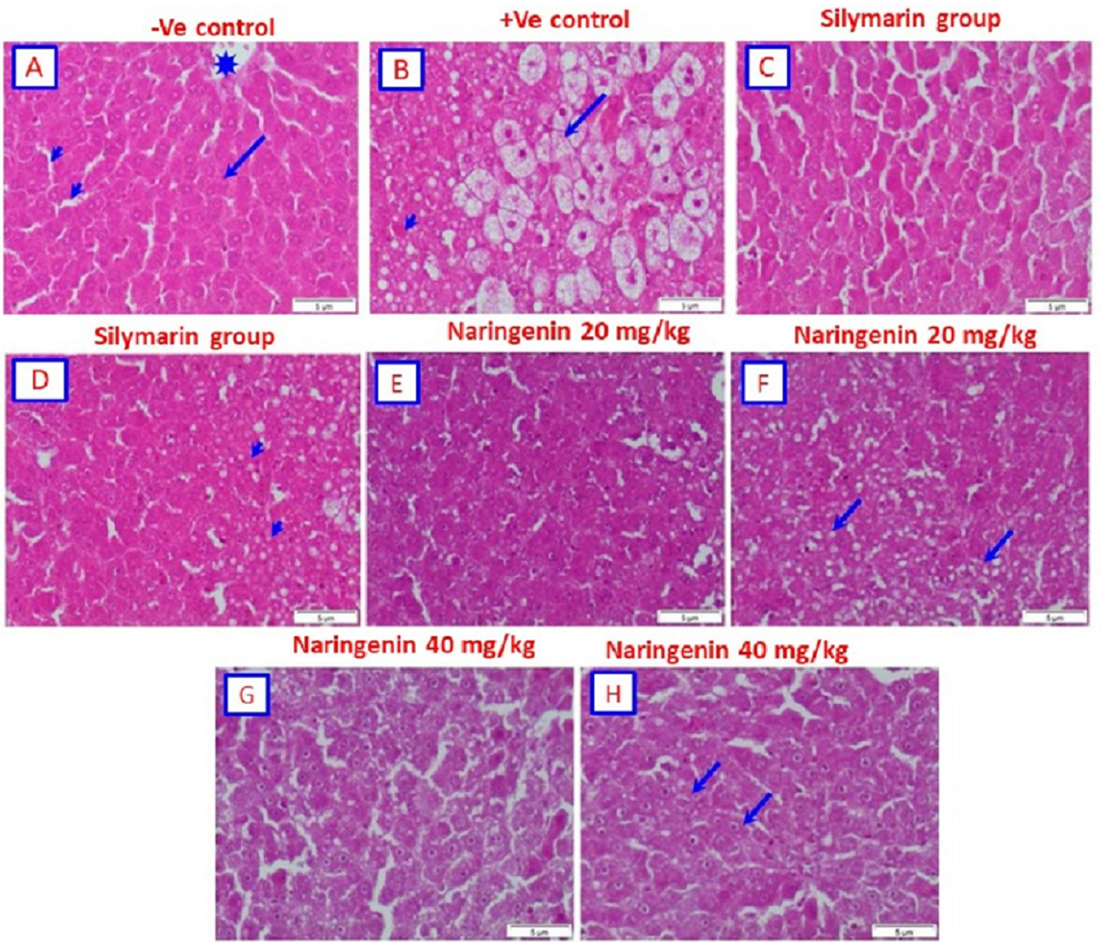
Figure 1. Photomicrograph of the liver tissues using hematoxylin and eosin (H&E) staining: ( A ) Negative control rats showing the normal structure of the hepatic lobule. The central vein (asterisk) is at the center of the lobule, which is surrounded by cords of hepatocytes (arrow). The hepatic sinusoids are shown between the strands of hepatocytes (arrowheads). ( B ) Rat given CCl 4 (positive control) showing large vacuoles in the cytoplasm with displacement of nuclei. The cytoplasm of the hepatocytes (arrowheads) has an even pale appearance, similar to ground glass. The hepatocytes undergo hydropic degeneration and become swollen and vacuolated (arrow), while some hepatocytes show an accumulation of eosinophilic material known as Mallory’s hyaline. ( C ) Rat given CCl 4 and treated with silymarin showing hepatocytes that appear as more or less normal. ( D ) Rat given CCl 4 and treated with silymarin showing hepatocytes associated with small vacuoles. ( E ) Rat given CCl 4 and treated with (20 mg/kg) naringenin showing hepatocytes that appear as more or less normal. ( F ) Rat given CCl 4 and treated with (20 mg/kg) naringenin showing hepatocytes associated with small vacuoles. ( G ) Rat given CCl 4 and treated with (40 mg/kg) naringenin showing hepatocytes that appear as more or less normal. ( H ) Eat given CCl 4 and treated with (40 mg/kg) naringenin showing several hepatocytes associated with small vacuoles (H&E; scale bar: 5 μ m).